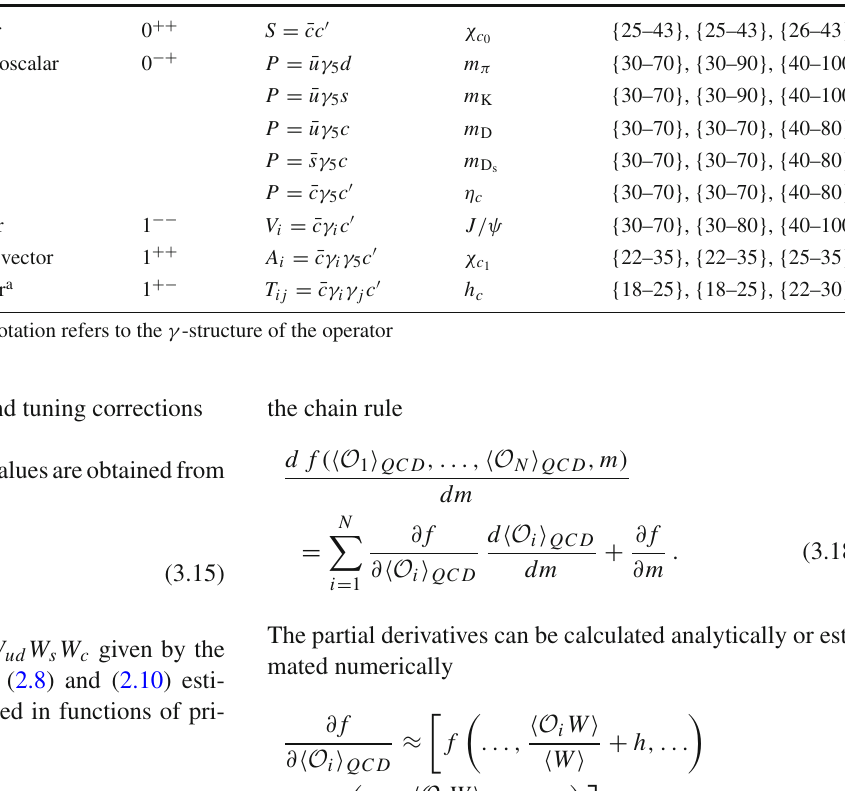
Table 1 Meson state interpolators and particle names which are the closest relatives in nature